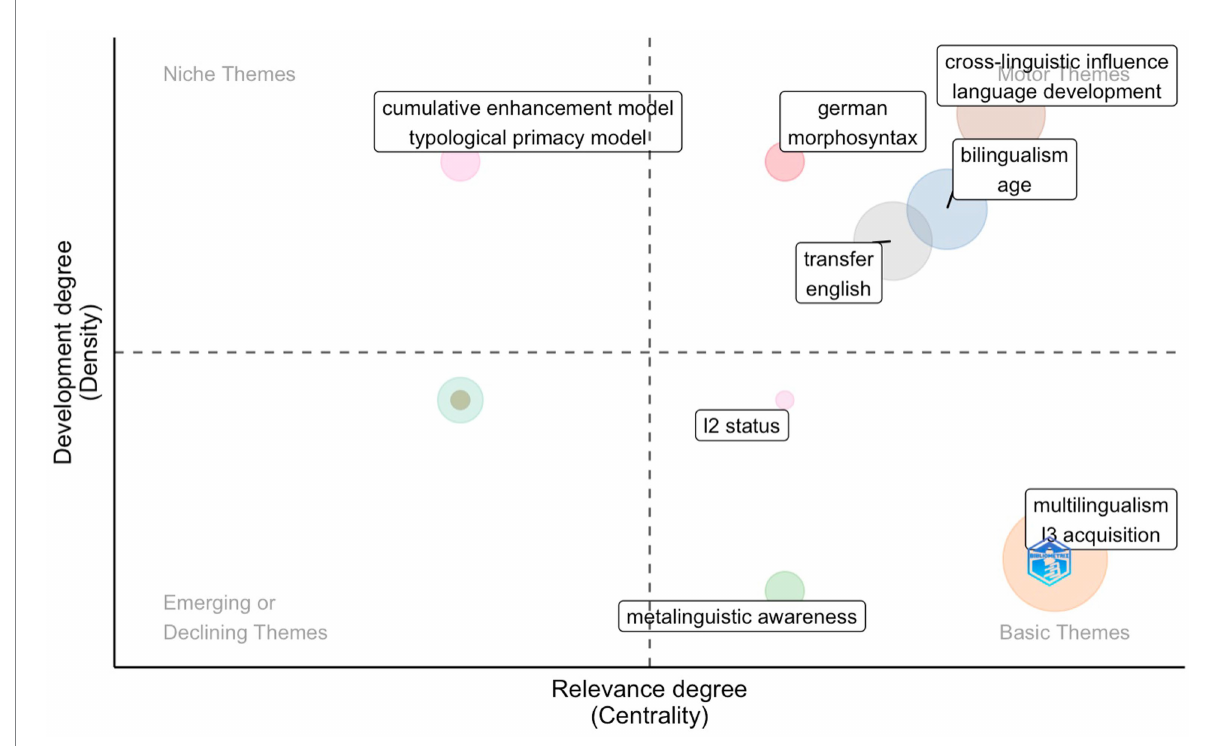
FIGURE 11 Thematic map showing clusters and the author’s keywords during the second period (2019-2014) identified by the co-occurrence